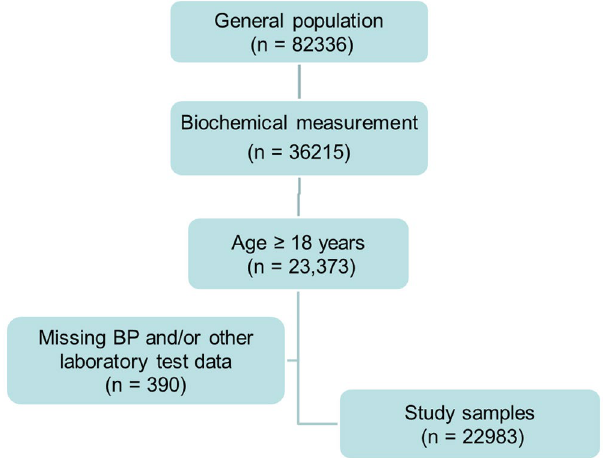
Figure 2. A schematic used for screening and inclusion of the study sample. A total of 82336 apparently healthy individuals were recruited between 2007 and 2011, and 36215 individuals had biochemistry measurements collected. Of the 23373 adults aged ≥ 18 years, 390 participants had missing data on BP and/or laboratory tests, and the final sample size was